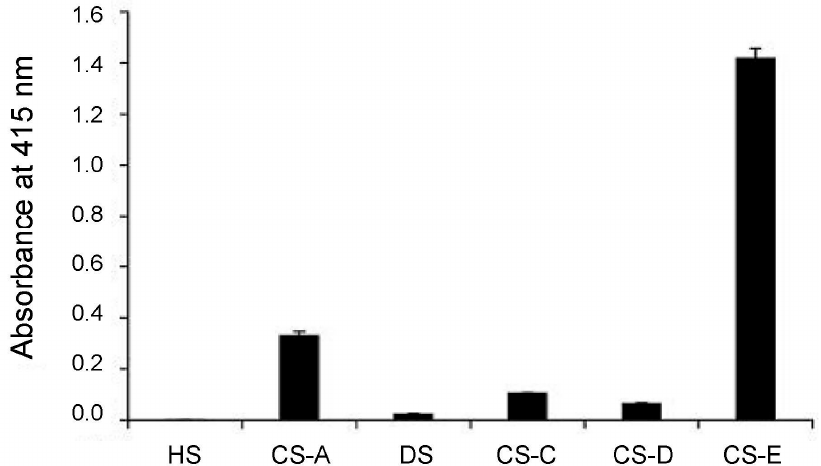
Figure 4. The reactivity of antibody GD3G7 with immobilized Heparin Sulphate (HS), CS-A, Dermatan Sulphate (DS), CS-C, CS-D, and CS-E was analyzed by indirect ELISA. Strong reactivity was observed with CS-E. Bars represent mean ± SD ( n = 3). (Reference [11]; Reproduced with permission from Elsevier B.V. Ltd. © 2007).